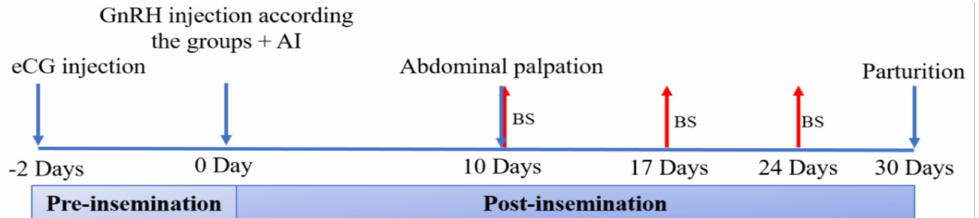
Figure 2. Experimental planning of trial 2, aiming to determine the effect of gonadotrophin-releasing hormone (GnRH) in different routes of administration on hormonal patterns (by means of successive blood samples; BS) and fertility and reproductive traits after artificial insemination